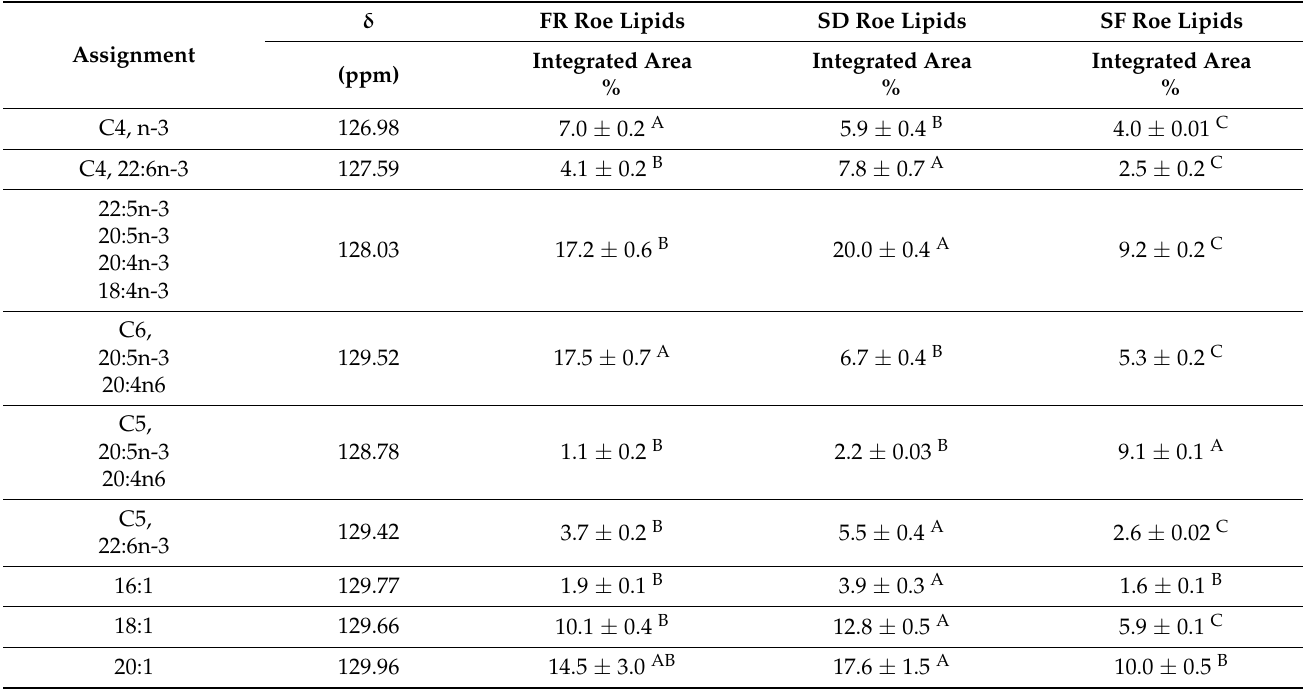
Table 2. 13 C NMR olefinic region of lipids extracted from fresh (FR), salted (SD), and fermented (SF) salmon